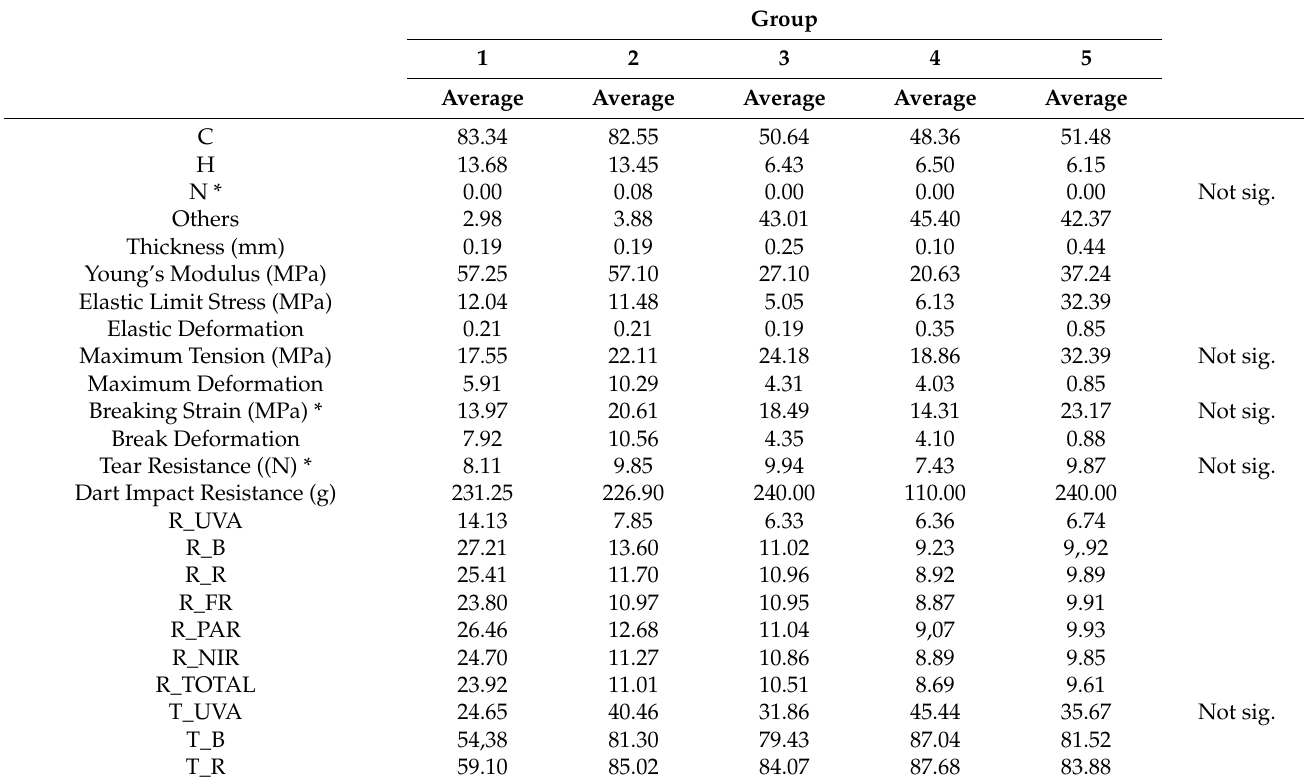
Table 9. Mean values corresponding to the five classification groups established by multivariate analysis of all chemical, radiometric and mechanical parameters of the polymeric films (Not Sig. = Not